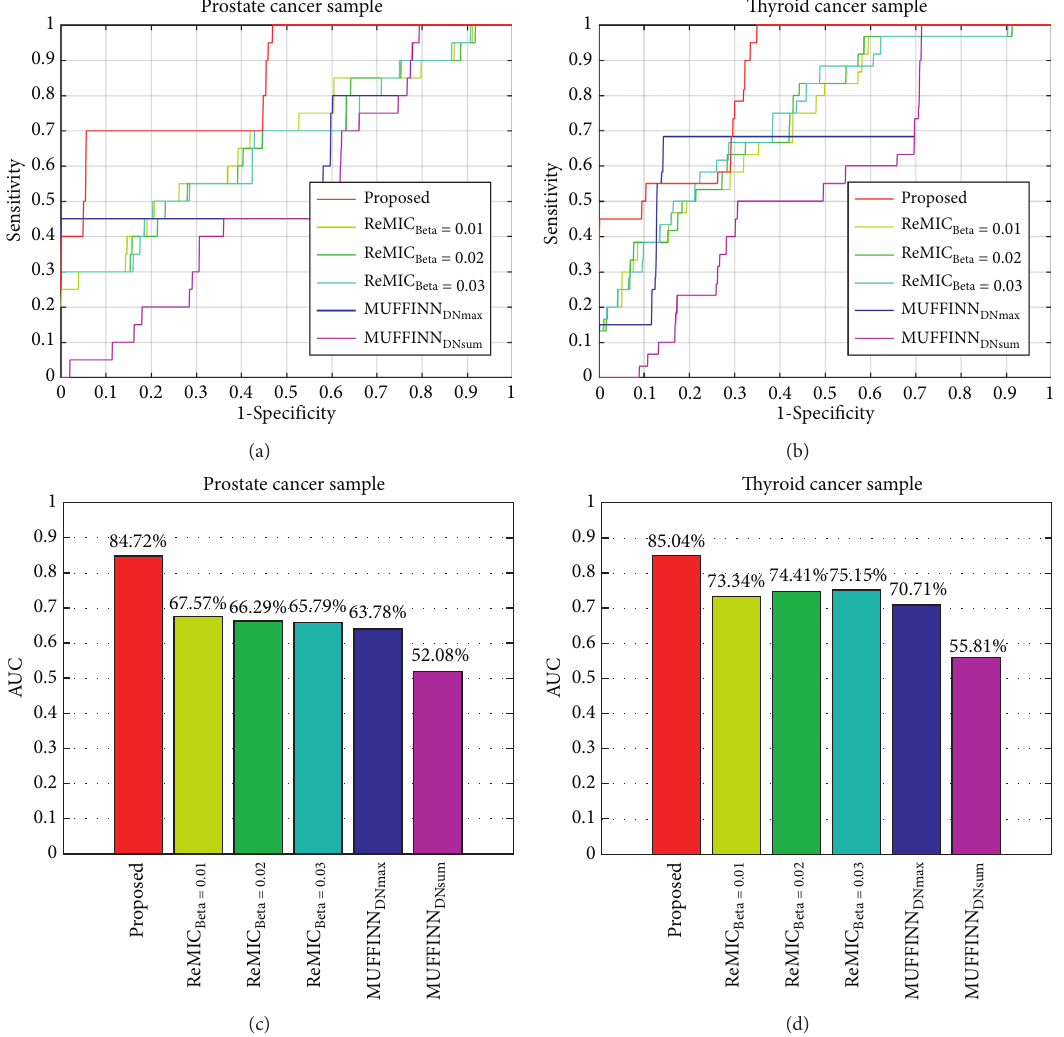
Figure 3: Performance evaluation of the compared methods on iRefIndex network via ROC curves and AUC values. (a) ROC curve for prostate cancer. (b) ROC curve for thyroid cancer. (c) AUC for prostate cancer. (d) AUC values for thyroid